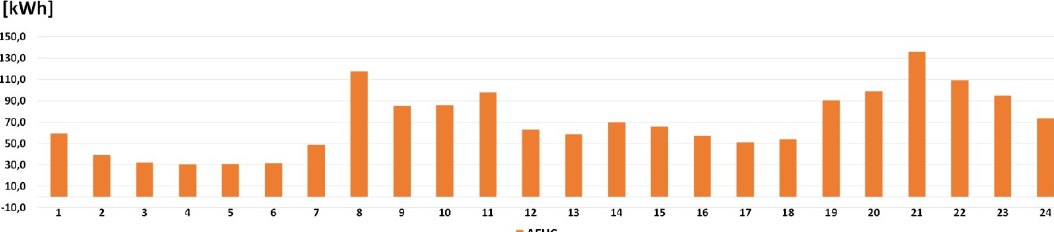
Figure 9. Aggregated hourly energy consumption of the energy community for the typical day of September.